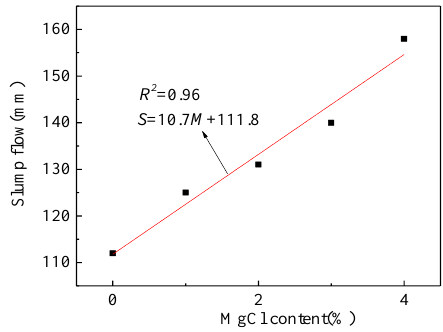
Figure 5. The slump flow of cement paste.